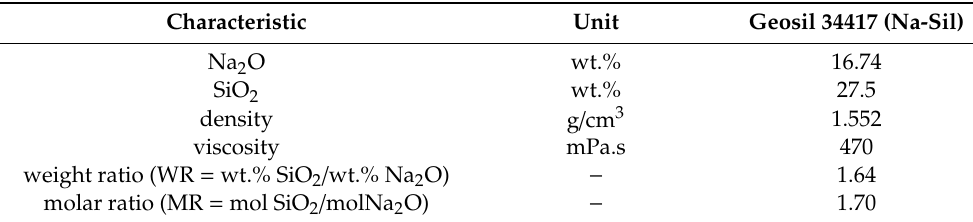
Table 3. Woellner Geosil silicate solution, data supplied by the producer. Characteristic